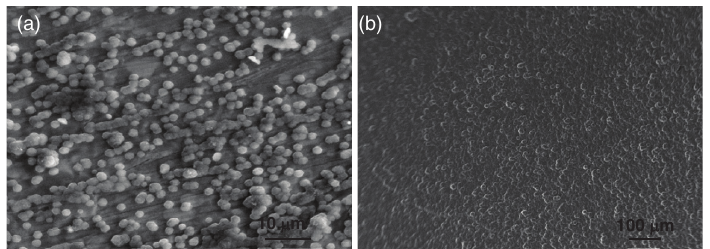
Figure 3: Surface SEM images of diamond formed on Kovar substrate precoated with an Al interlayer after deposition for 1 h (a) and 6 h (b), respectively.